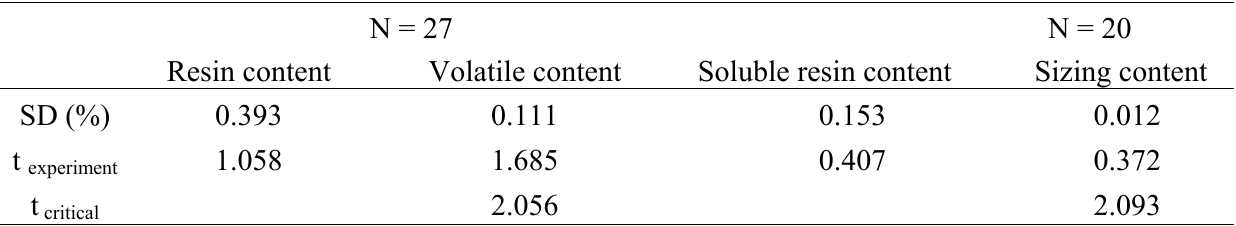
Table 5. Results of the paired t-test on NIR prediction and actual values for the prediction